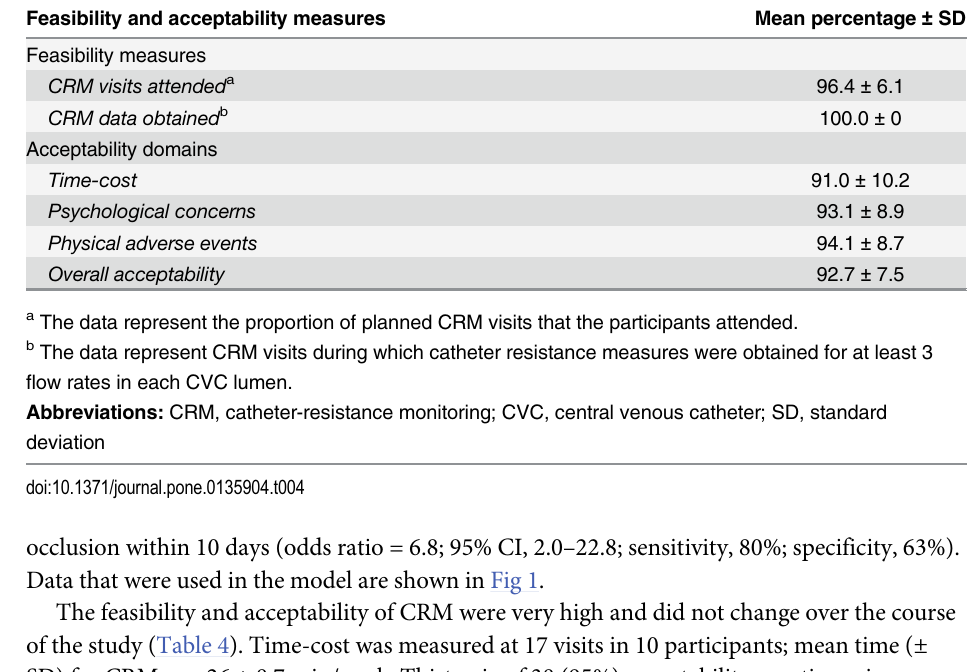
Table 4. Feasibility and acceptability of catheter-resistance